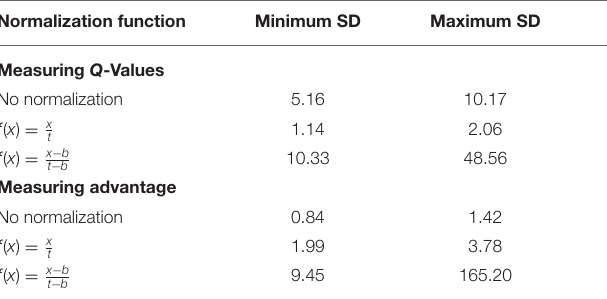
TABLE 1 | The minimum and maximum SD when evaluating 28 different parameter combinations of Occlusion Sensitivity saliency maps with an insertion metric using different normalization